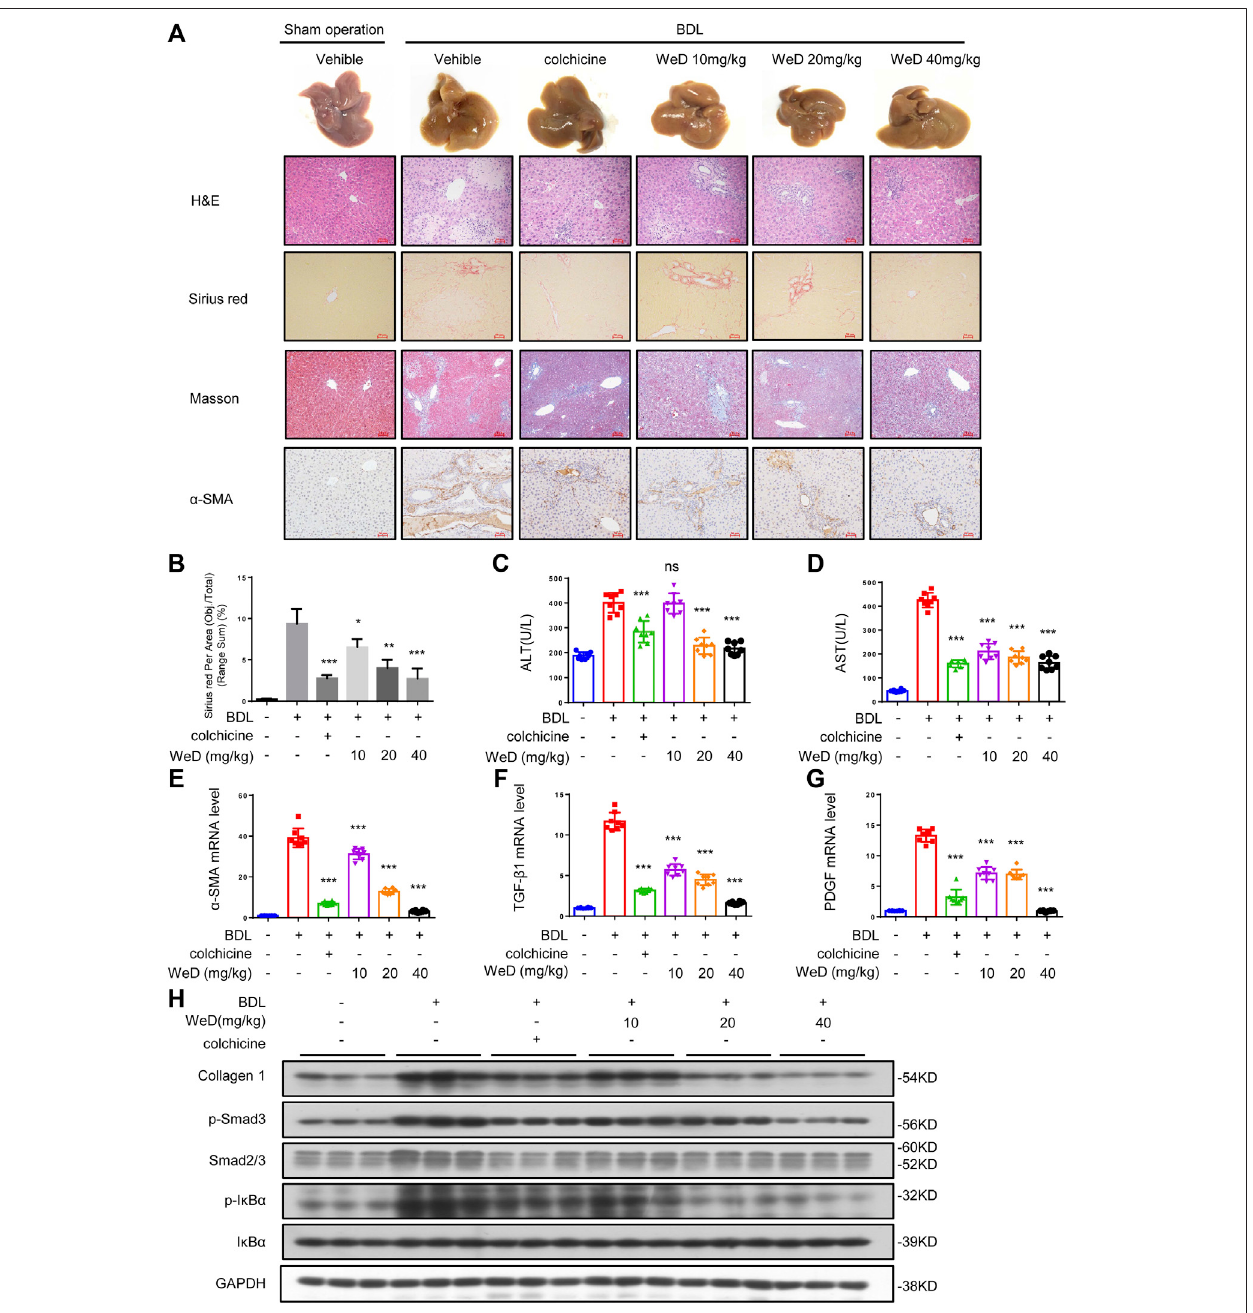
FIGURE4| WeDattenuateshepaticinjuryand fi brosisinducedbyBDLinmice (A) Imagesofliversfromsham-operatedmice(SHAM),bileduct-ligatedmice(BDL), BDL-mice treated with WeD. Representative micrographs of liver H&E staining, Sirius red, Masson staining, and α -SMA were shown. Scale bars represent 50 μ m (B) Quantitative results of Sirius red staining sections (C,D) Serum level ofALT (C) and AST (D) of sham-operated mice (SHAM), bile duct-ligated mice (BDL) and BDL-mice treatedwith WeD or colchicine (0.2 mg/kg) (E – G) Quantitative PCRanalysis ofmRNAlevels of α -SMA (E) , TGF- β 1 (F) ,and PDGF (G) inliversfrom sham-operated mice,BDL mice,BDL-micetreated withWeD (H) WesternblotanalysisofCollagen1, p -Smad3, Smad2/3,P-I κ B α ,I κ B α and GAPDHin liversfrom sham-operatedmice, BDL mice, BDL-mice treated with WeD. Data are expressed as Mean ± SD ( n (cid:2) 8 or 3 mice). Statistics differences were analyzed using One-way ANOVA followed by Dunnett ’ s test: * p < 0.05, ** p < 0.01, *** p < 0.001. NS, no signi fi cance.